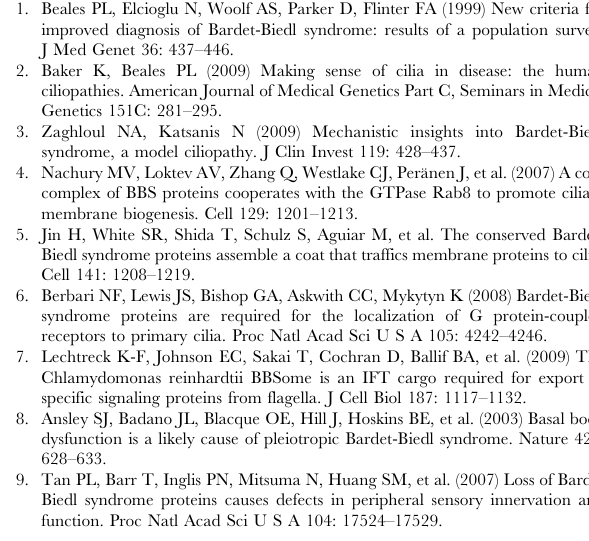
Figure S1 Dye-filling phenotype of BBSome mutants. (PDF) Figure S2 Increased secretion of BBSome mutants depends on IFT. Transition zone mutants do not increase secretion. (PDF) Figure S3 BBSome mutants have normal expression of neuropeptide genes. (PDF) Figure S4 Tomosyn and BBSome mutants have additive Nile Red phenotype. Pumping phenotype of BBSome mutants is not caused by increased expression of tph-1 . (PDF) Figure S5 Dense-core vesicle marker, IDA-1, localized to cilia in bbs mutants. (PDF) Table S1 Tissue-specific rescue of bbs mutants.